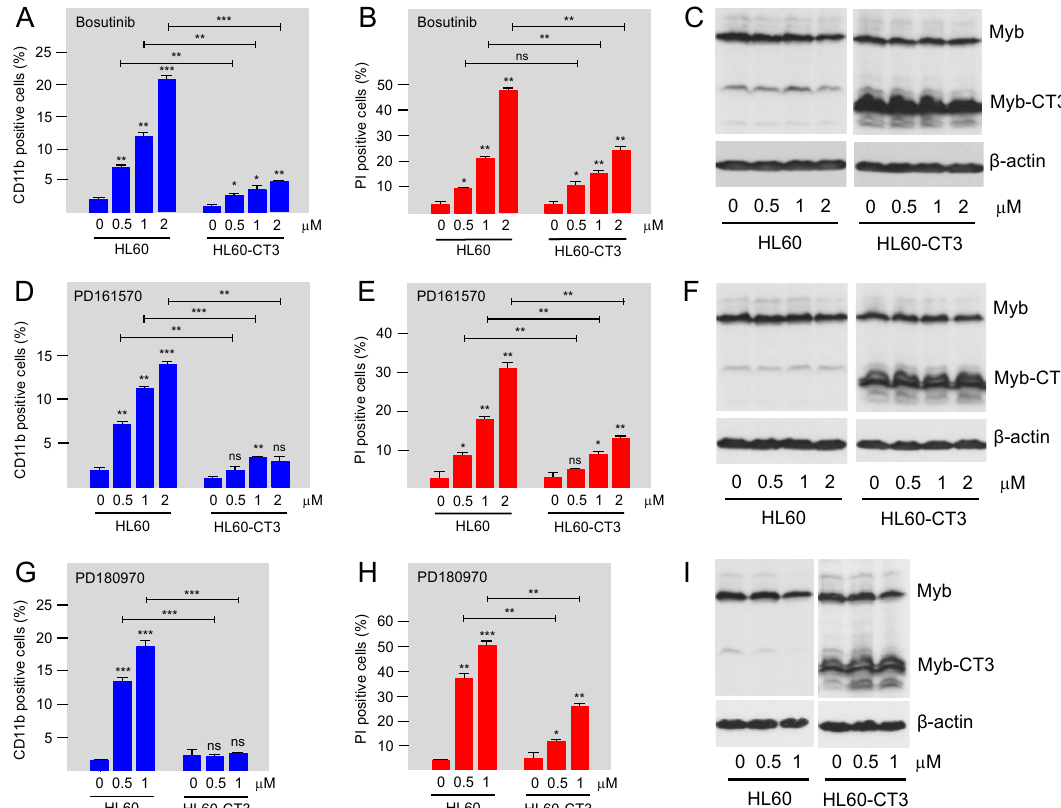
Figure 6. Kinase inhibitors affect HL60 cells in a MYB-dependent manner. HL60 cells infected with a control lentivirus or a lentivirus encoding C-terminally truncated MYB (HL60-CT3) were treated for 48 h with the indicated concentrations of Bosutinib (panels A to C ), PD161570 (panels D to F ), and PD180970 (panels G to I ). The cells were then analyzed by flow cytometry for CD11b expression (panels A , D , G ), by staining with propidium iodide (panels B , E , H ), and by Western blotting for MYB and β -actin expression (panels C , F , I ). Asterisks indicate statistical significance (ns: not significant; * p < 0.05; ** p < 0.01; *** p < 0.001; Student’s t